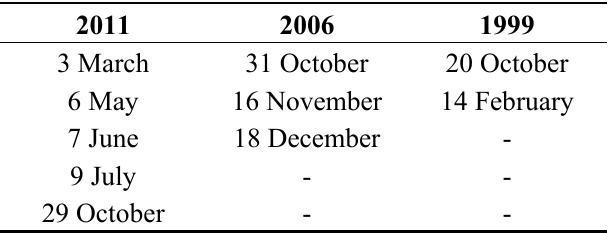
Table 1. Landsat TM images of 2011, 2006 and 1999.